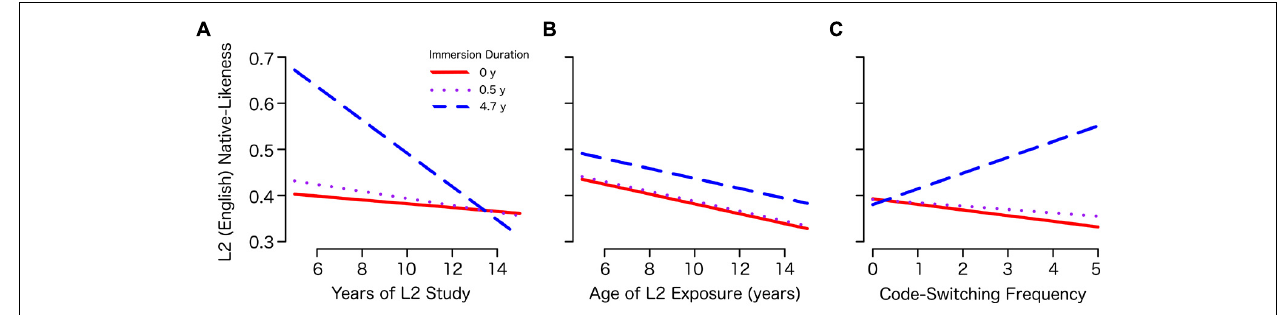
FIGURE 3 |Two-way interaction plots for Immersion and each of the learner variables. (A) Years of L2 study. (B) Age of earliest L2 exposure. (C) Self-reported frequency of code-switching.